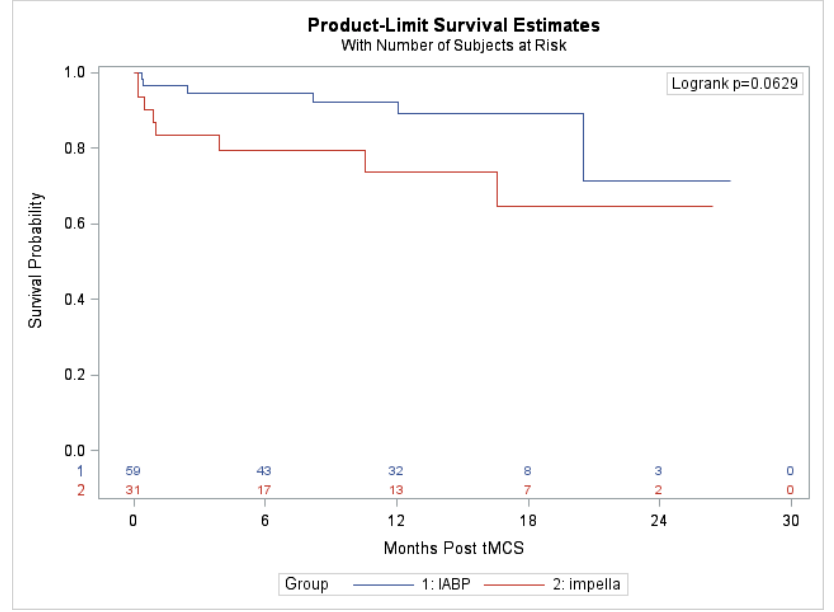
Figure 2. Survival analysis for patients with Impella vs. IABP placed for cardiogenic shock. There was no significant difference in the proportion of patients that experienced re- covery (17% vs. 9.7%; p = 0.53) transitioned to durable MCS (3.4% vs. 3.2%; p = 1.0; Figure 3), or underwent heart transplantation (67.7% vs. 76.3%, p = 0.455).